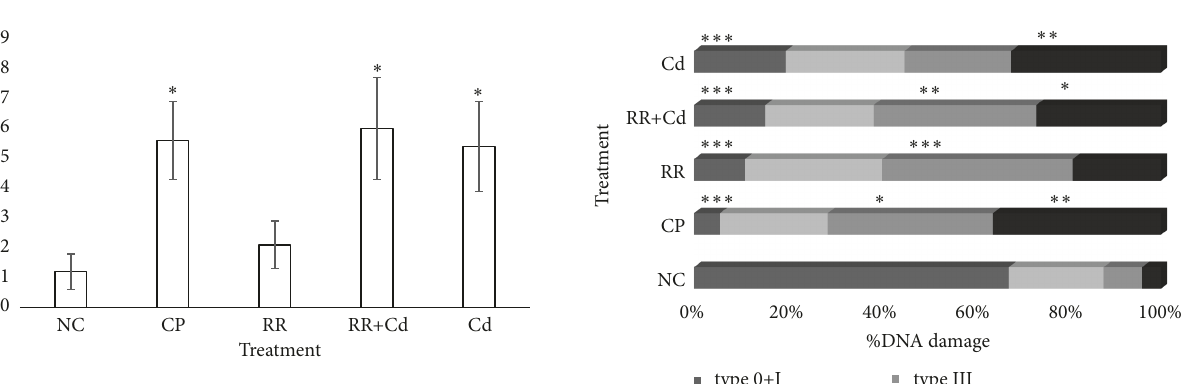
Figure 3: Analysis of micronuclei frequency in peripheral blood erythrocytes of Cnesterodon decemmaculatus exposed to different treatments. Treatments: NC (negative control, MHW); CP (positive control, 5 mg cyclophosphamide/L); RR (surface water of the Reconquista River); RR+Cd (surface water of the Reconquista River with 2 mg Cd/L); Cd (2 mg Cd/L). ∗ p < 0.05 compared to NC. Number of individuals analyzed in each treatment: 16-22.